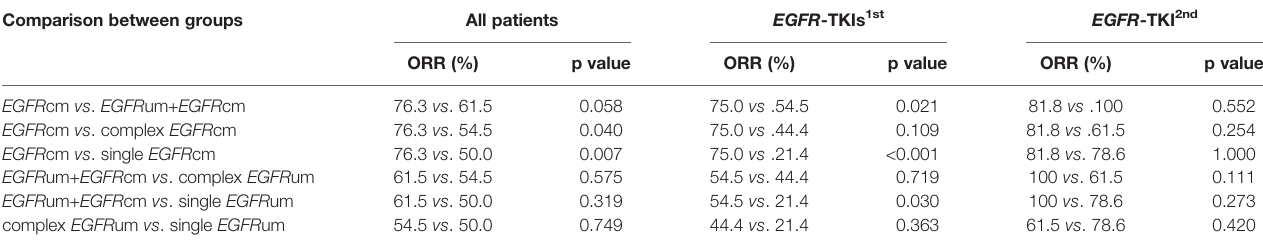
TABLE 1 | Therapeutic responses among patients with different mutation patterns. Comparison between groups All patients